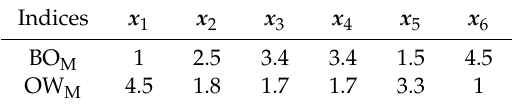
Table 7. The BO M vector and the OW M vector.